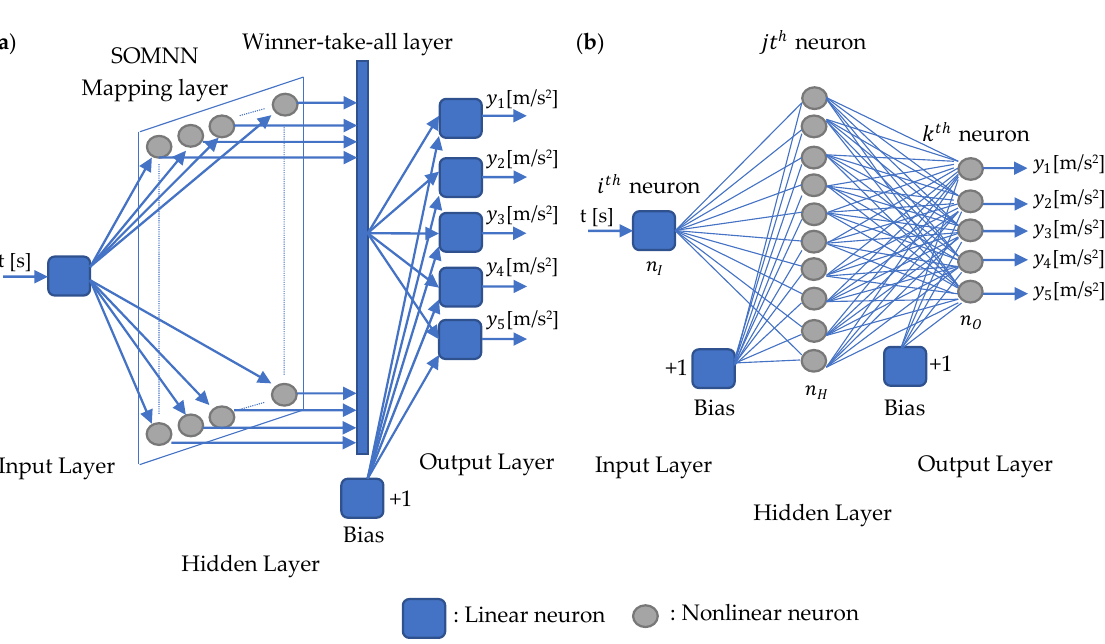
Figure 4. ( a ) Self-organizing map neural network (SOMNN) [29]. ( b ) Radial basis function neural network (RBFNN) [29].